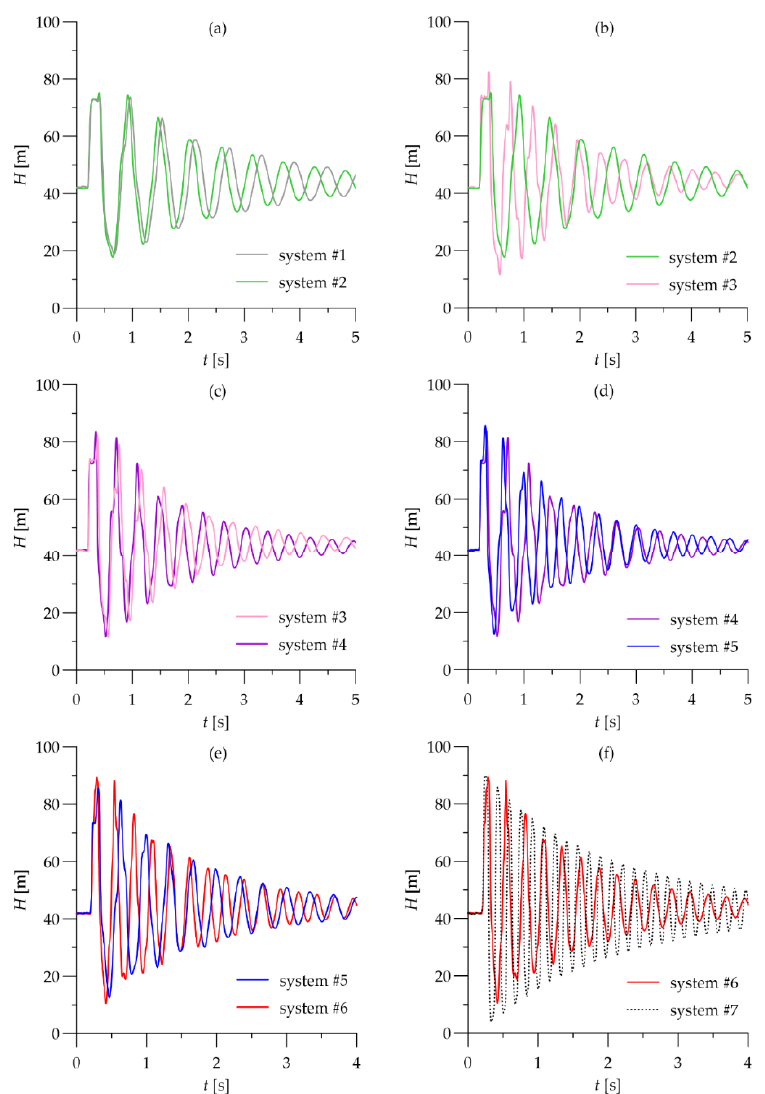
Figure 3. Comparison between experimental transient data: ( a ) System #1 vs. system #2; ( b ) System #2 vs. system #3; ( c ) System #3 vs. system #4; ( d ) System #4 vs. system #5; ( e ) System #5 vs. system #6; and ( f ) System #6 vs. system #7.